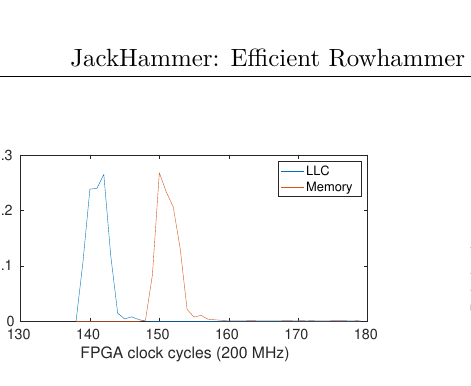
Figure 11: Latency for PCIe read requests on an FPGA PAC served by the CPU’s LLC or main memory.